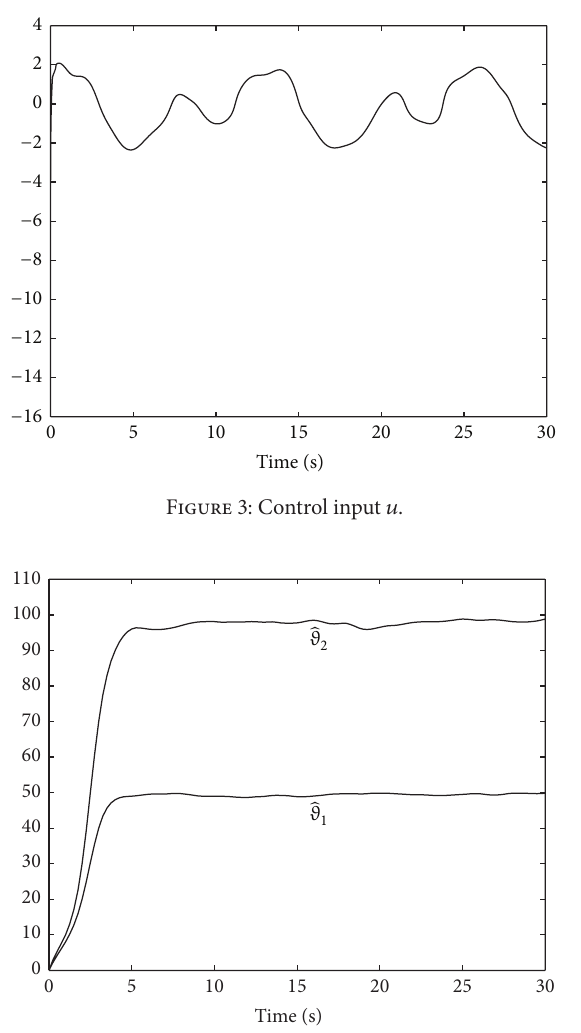
̂𝜗 ̂𝜗 1 and 2 . Figure 6: Trajectories of system output 𝑦 and reference signal 𝑦 𝑑